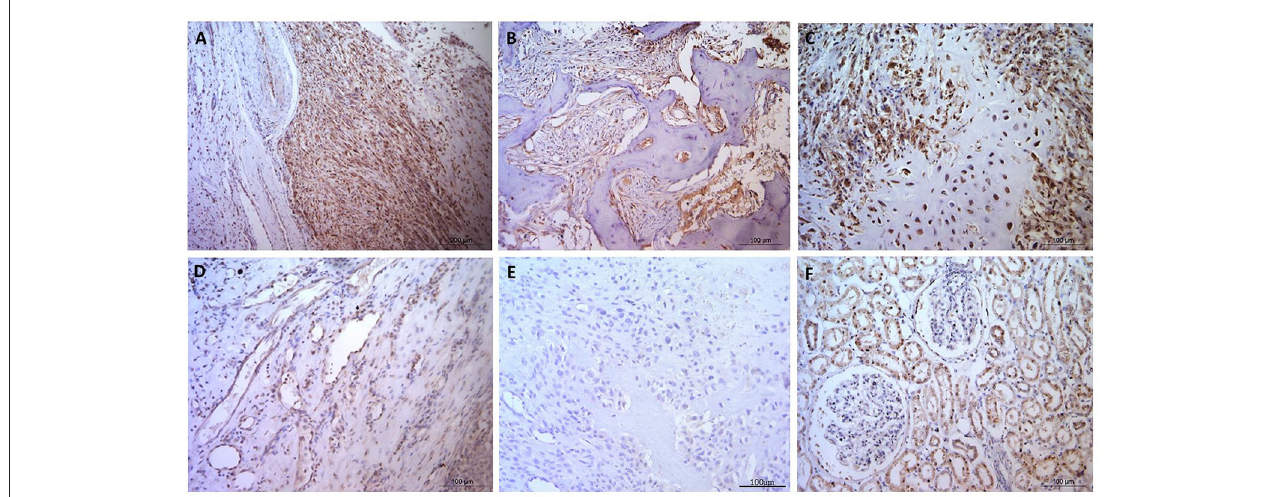
FIGURE 2 | Osteosarcoma GLUT1 immunohistochemical staining. (A–C) GLUT1 indicating positive nuclear and cytoplasmic immunostaining, immunopositive blood vessels with more pronounced cytoplasmic staining in the tunica intima in comparison to the tunica media, and negative staining in the osteoid and in (D) a tumor-free